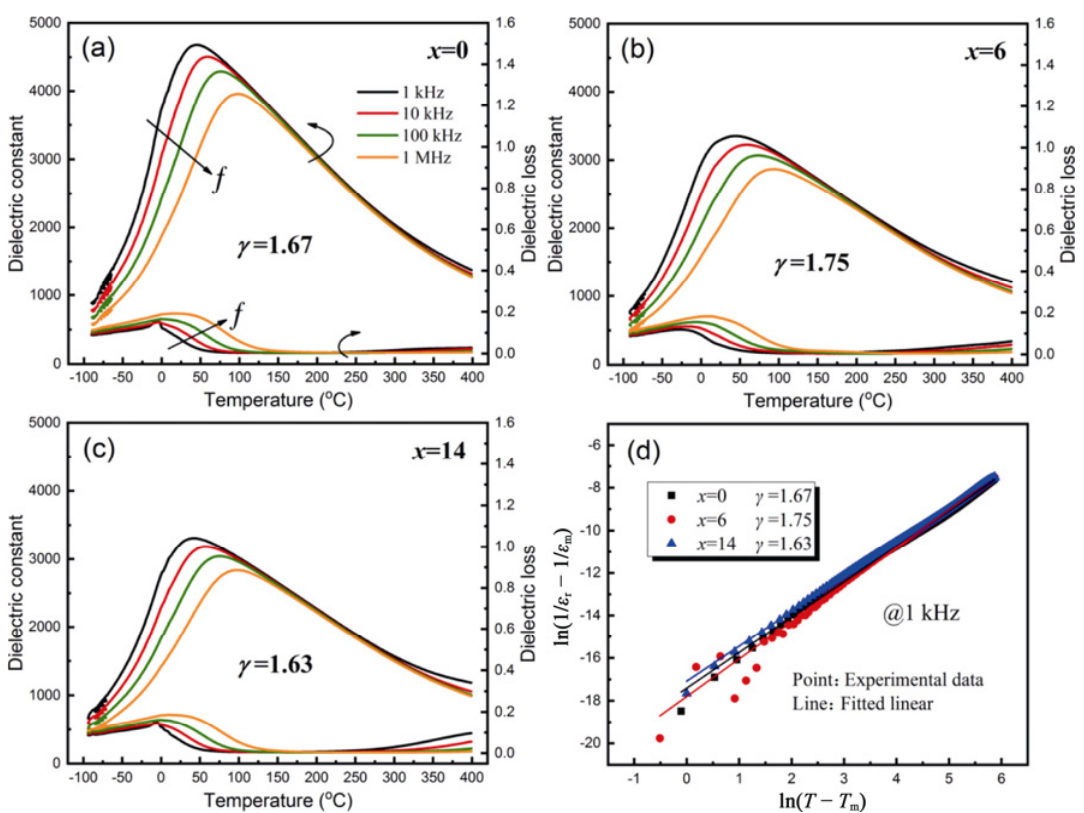
Fig. 5 Dielectric constants of (a) BS 0.5 BNT, (b) BS 0.5 BNT–6GS, and (c) BS 0.5 BNT–14GS samples as a function of temperature at frequencies of 1 kHz, 10 kHz, 100 kHz, and 1 MHz. (d) Fitting pattern of ln(1/ ε r − 1/ ε m ) vs. ln( T − T m ) for BS 0.5 BNT– x GS ceramic composites at 1